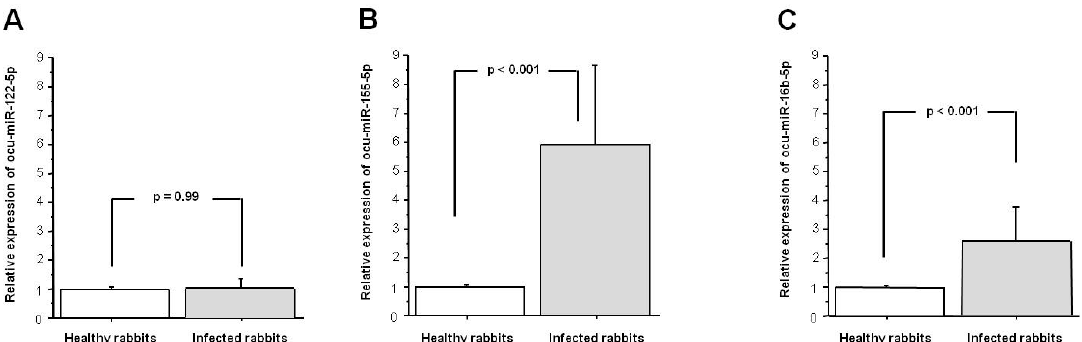
Figure 1. Expression of ( A ) ocu-miR-122-5p; ( B ) ocu-miR-155-5p; and ( C ) ocu-miR-16b-5p in the liver tissue from infected rabbit hemorrhagic disease virus (RHDV) rabbits in comparison with the healthy rabbits. Relative expression data were normalized to use ocu-let-7a-5p and ocu-miR-103a-3p as stable reference genes. Results are shown as the mean ± standard error, and p < 0.05 was considered significant.